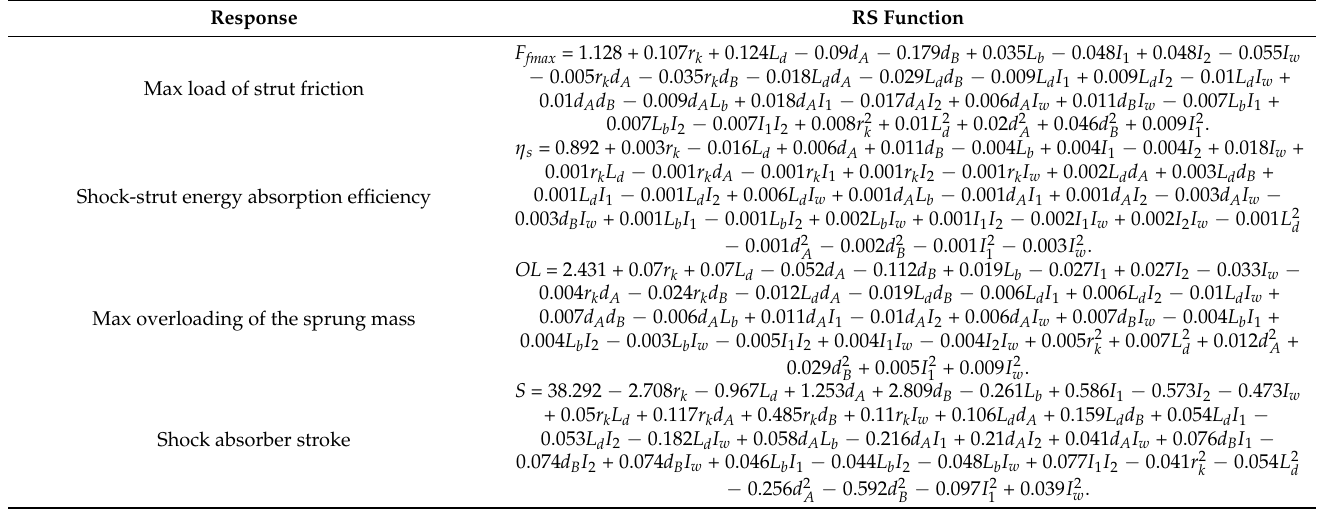
Table 9. RS functions for the four landing dynamic